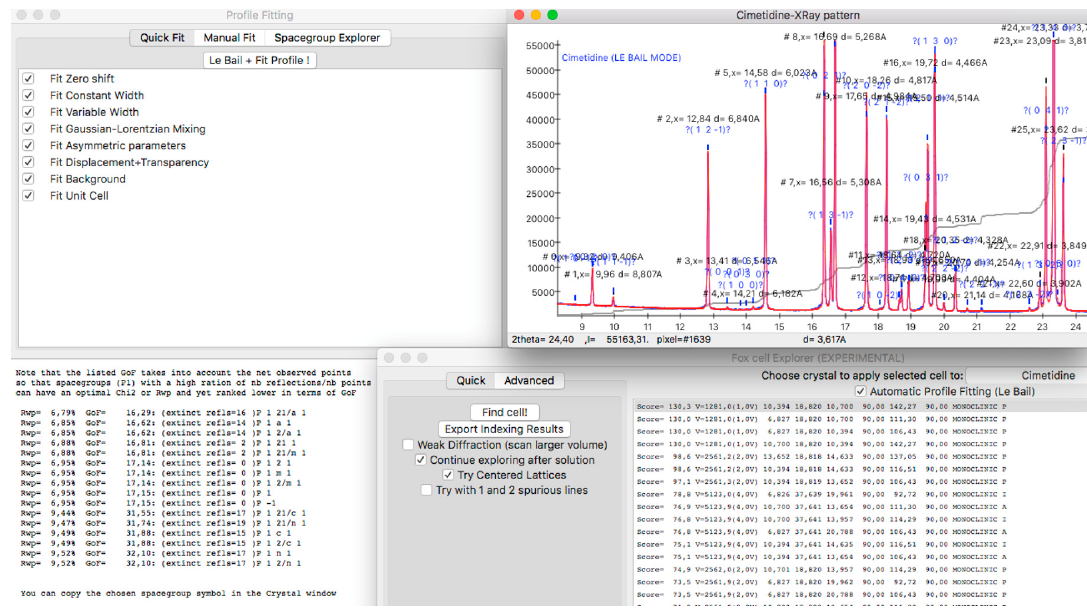
Figure 1. FOX 2017.2 indexing and profile fitting interface. Top left : profile fitting widget, allowing to select groups of parameters to optimize using Le Bail and full-profile least squares. Bottom left : result of the space group explorer, where all space groups compatible with the unit cell are tested and listed with increasing Goodness-of-Fit. The correct choice in this case is the first one, with the highest number of systematic extinctions. Top right : zoomed portion of the observed and calculated powder pattern in profile fitting (Le Bail) mode, with the list of peaks found and predicted indexing. Bottom right : results from a ‘quick’ indexing, with solutions listed by decreasing M 20 score.